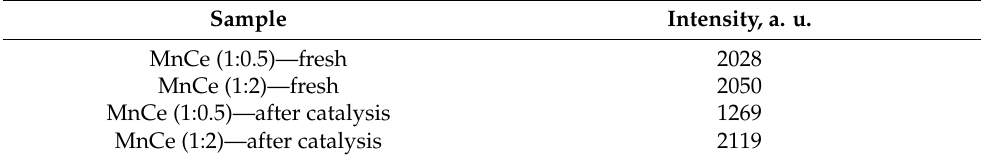
Table 3. Values of the intensities of the EPR spectra of the studied catalysts. Sample Intensity, a. u.